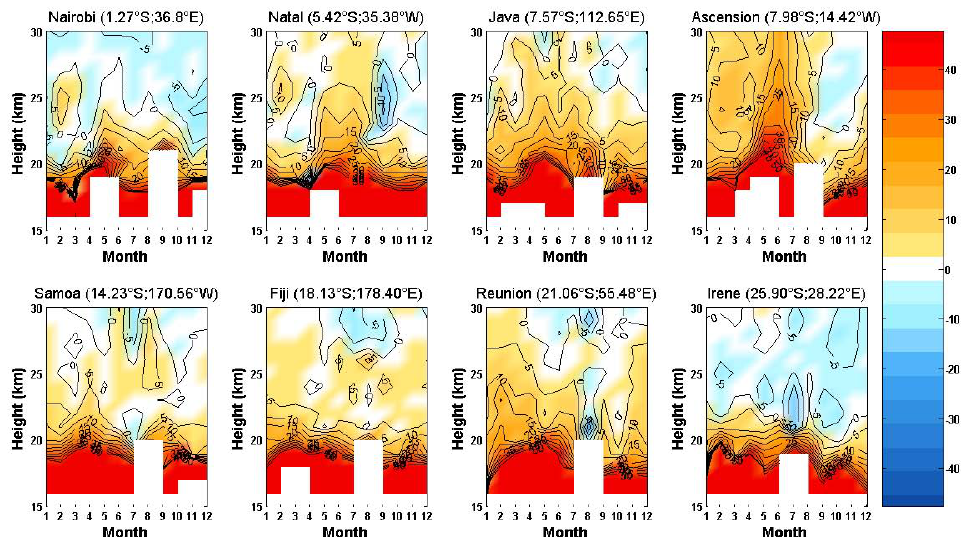
Fig. 5. Monthly distributions of the relative percentage of differences between GOMOS and SHADOZ observations (these differences are based on comparisons of monthly means). It is calculated with respect to ground based measurements in the altitude range between 15km and 30km. The contours are separated by